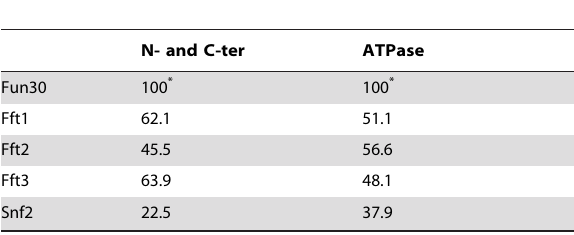
Table 1. Identity between Fun30 protein sequence and the sequences of the related Fft proteins and of